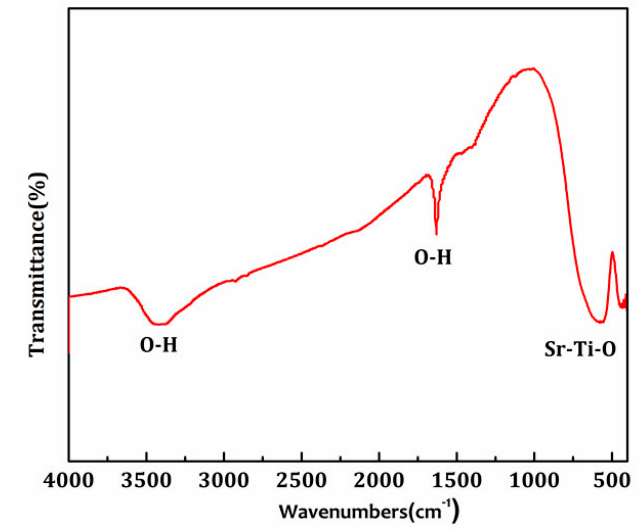
Figure 4. FTIR spectra of pure SrTiO 3 .